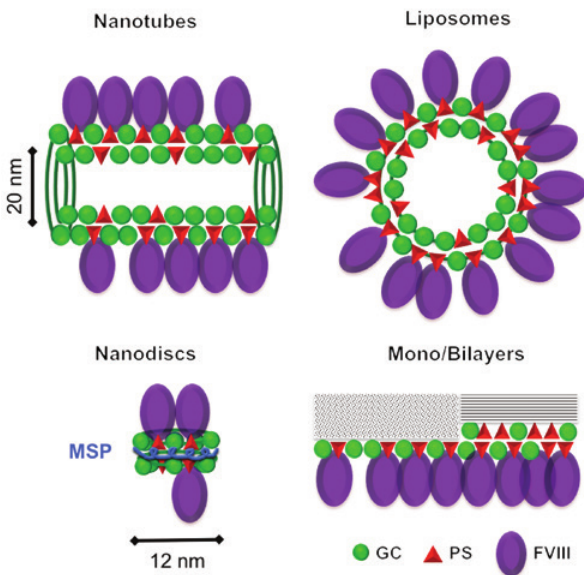
Figure 1: Lipid nanotechnologies for structural studies of mem- brane-associated proteins. The lipid nanotechnologies optimized in our laboratory for structural studies of factor VIII (FVIII) by CryoEM are shown. FVIII binds specifically to phosphatidylserine (PS)-rich lipid membranes, which is overexpressed on the activated platelet membrane in vivo . Nanotubes are single bilayer lipid nanotubes (LNTs) self-assembled from galactosylceramide (GC) that can incor- porate a specific ligand similar to the lipid layer technique [39, 45]. Nanodiscs (NDs) are bilayer patches held together by membrane scaffolding proteins (MSPs) that can be assembled from various phospholipid mixtures, including GC at different contents of PS and lipids-to-MSP ratio [32, 35]. Liposomes are single bilayer lipid vesicles that can be assembled from various lipid mixtures and used to complement the lipid monolayer structural studies at the lipid compositions required for coagulation factors [38, 40]. Monolay- ers are lipid monolayers stabilized at the air/buffer interface that have been assembled at the same PS content as LNT and ND for 2D crystallization of membrane-bound coagulation proteins [37, 38, 40, 44]. Bilayers are lipid bilayers supported by a solid surface and have proven to be more suitable for AFM